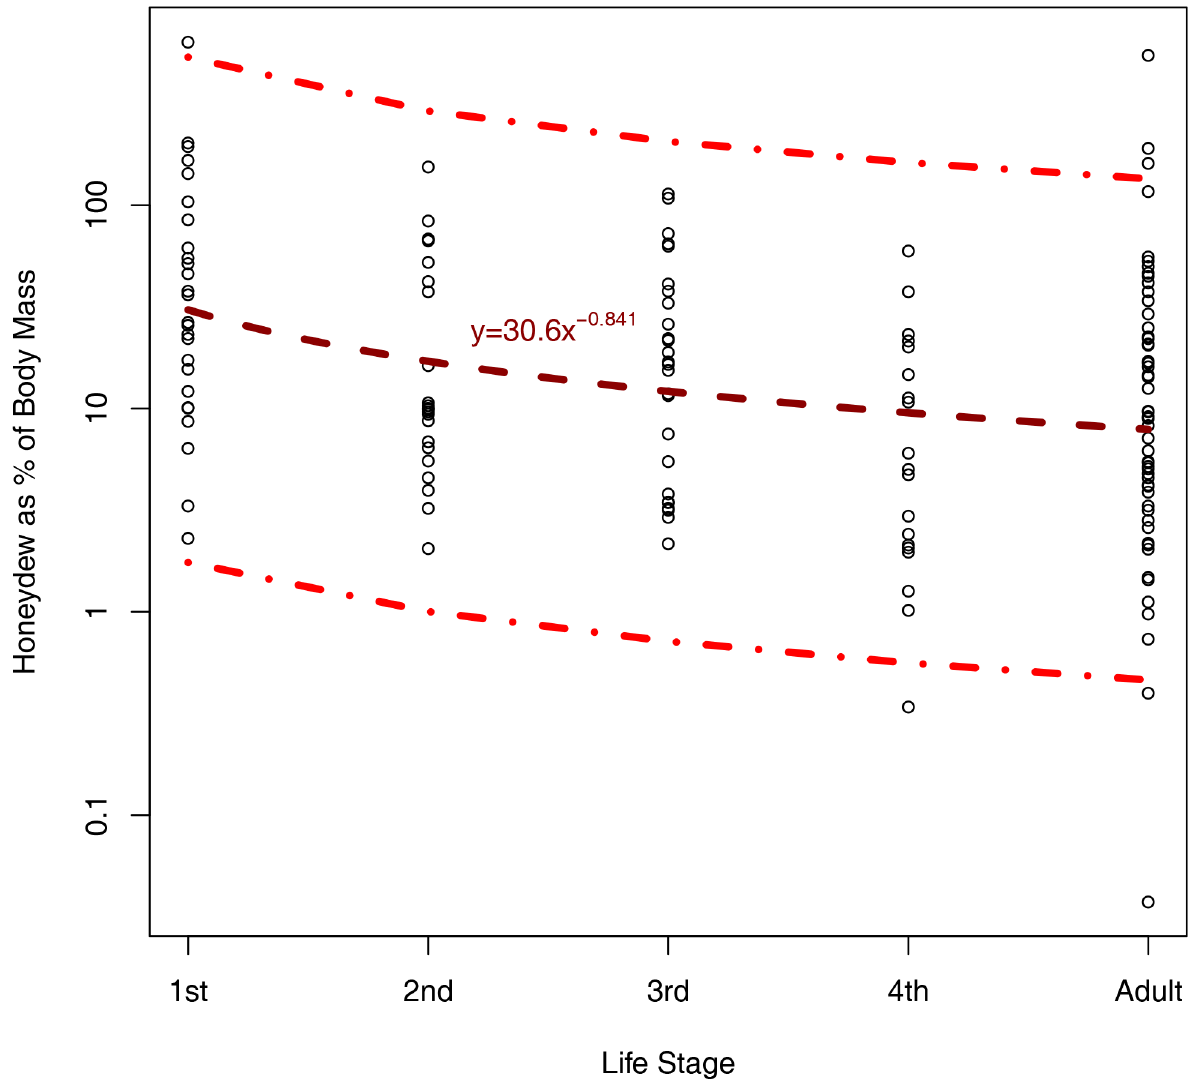
Fig 2. Honeydew produced as a percentage of hemipteran wet body mass ( μ g) per hour against life stage of Hemiptera for 21 species (see S1 Appendix), showing actual values (circles), power model prediction (dark dashed line) and 95% prediction interval (lighter dash-dotted lines). and median percentage error 25%, Psyllidae: mean percentage error 35% and median percent- age error 35%) but unreliable due to the paucity of data. Honeydew prediction Method 2: Life stage and body mass Hemipteran families displayed a consistent pattern of rapid honeydew production as early instars, slowing with size and life stage (Fig 2). All three models (power, exponential and lin- ear) predicting the honeydew produced as a percentage of body mass and as a function of hemipteran life stage were highly significant. This indicates that honeydew production varies with life stage and thus knowing life stage increases predictive power ( p < 0.001 in each case). The power model y = 30.6x -0.841 was the best model, indicated by a lower AIC than the exponential and by-factor models (Fig 2, Δ AIC = 2.04 and 2.18, Δ AICc = 2.04 and 2.60,